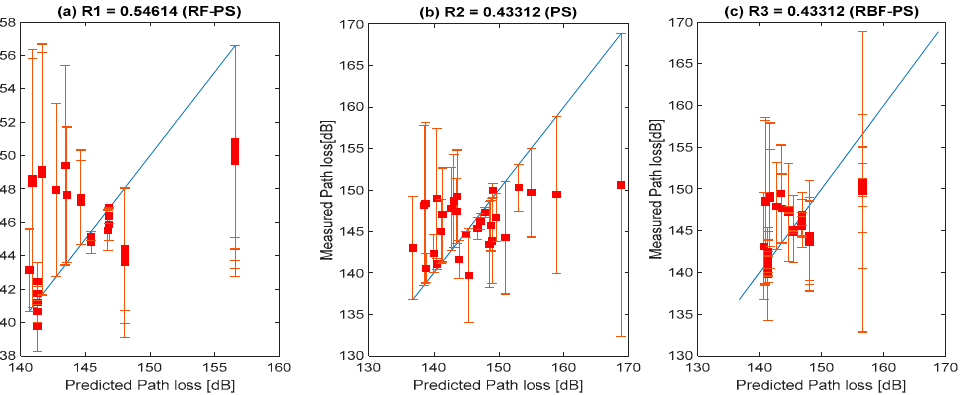
Figure 24. Results showing the correlation between the measured path loss and predicted path loss using the hybrid RF-PS prediction method and two existing standard path loss prediction methods in site 2 of location 2.